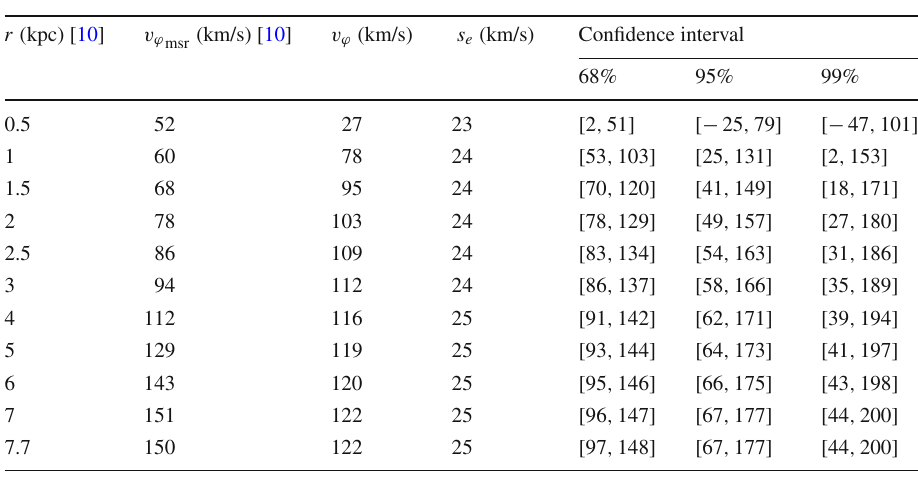
calculated velocities, standard errors and confidence intervals for the NGC 1087 galaxy